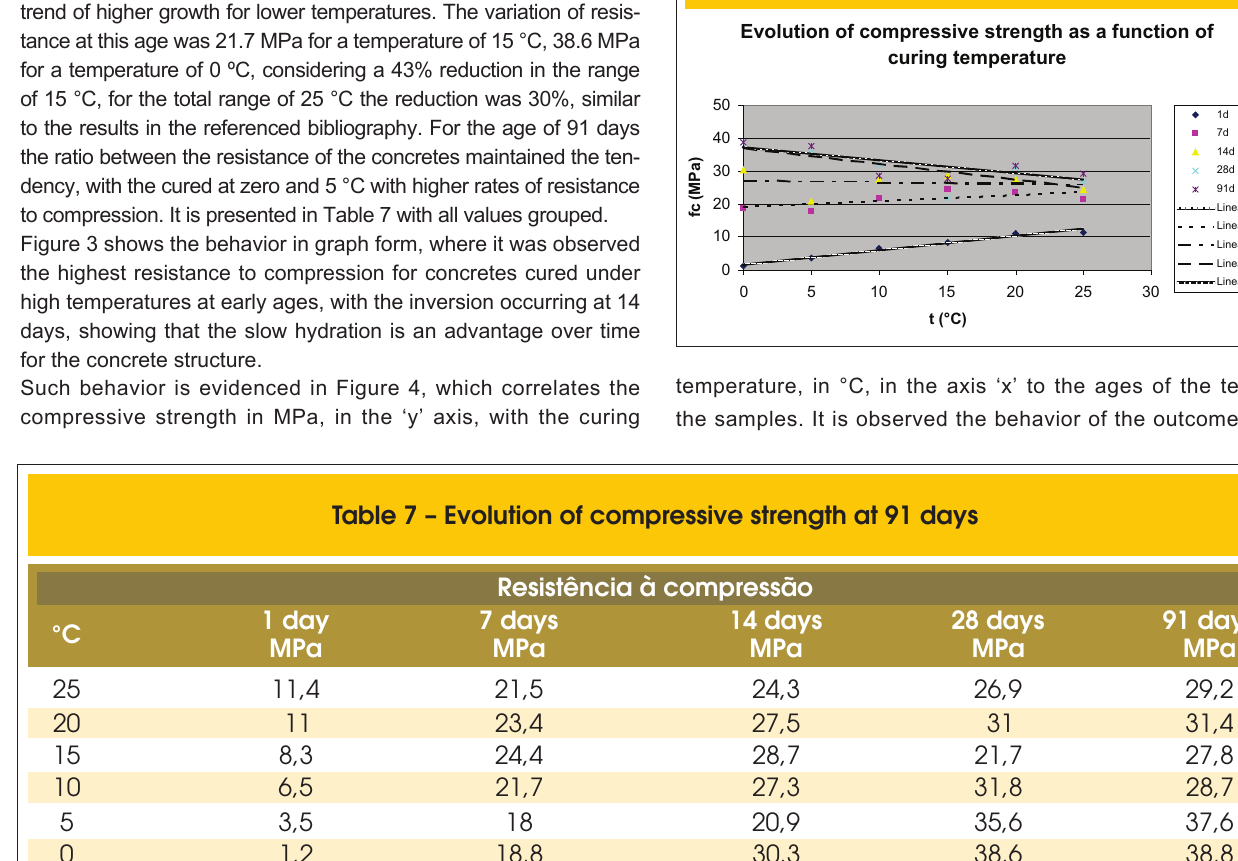
Figure 4 – Evolution of compressive strength as a function of curing